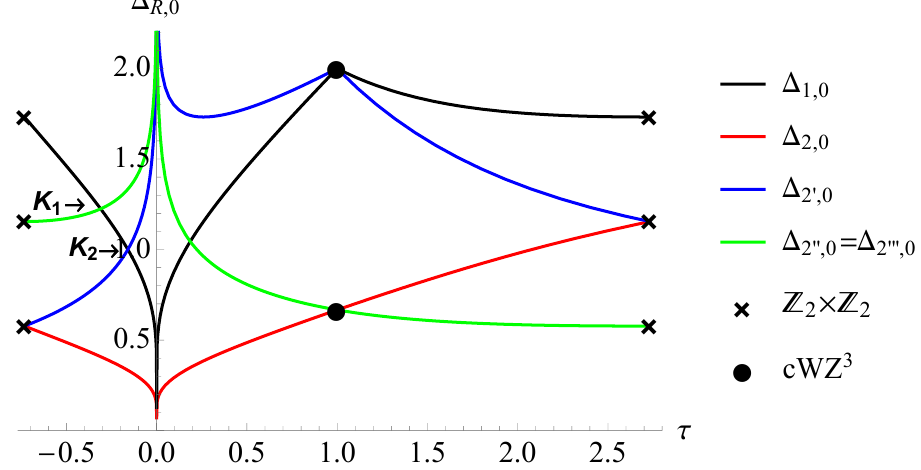
(cid:0)p p 3 (cid:20) (cid:28) (cid:20) 1+ 3. (cid:6)p 3 ; 1 for the Z 2 (cid:2) Z 2 and cWZ 3